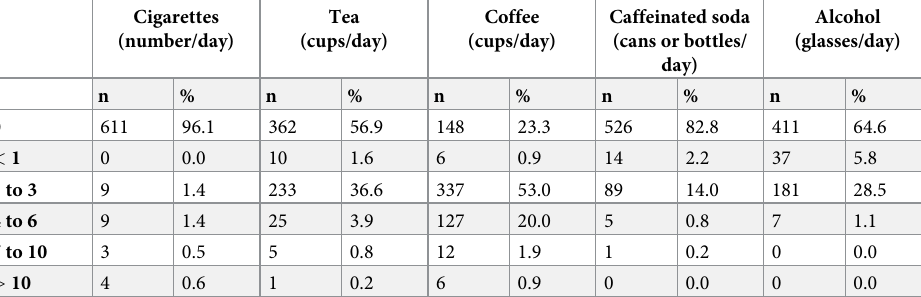
Table 2. Use of substances affecting